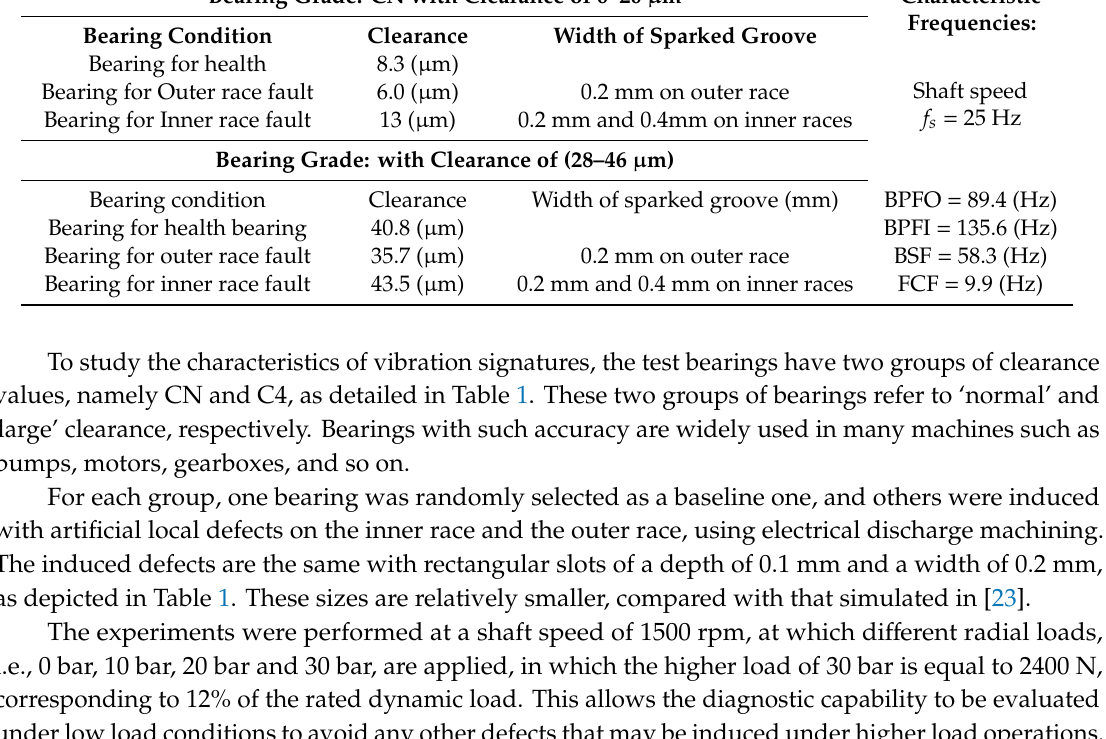
Table 1. 6206 deep groove ball bearing clearance values and local defect